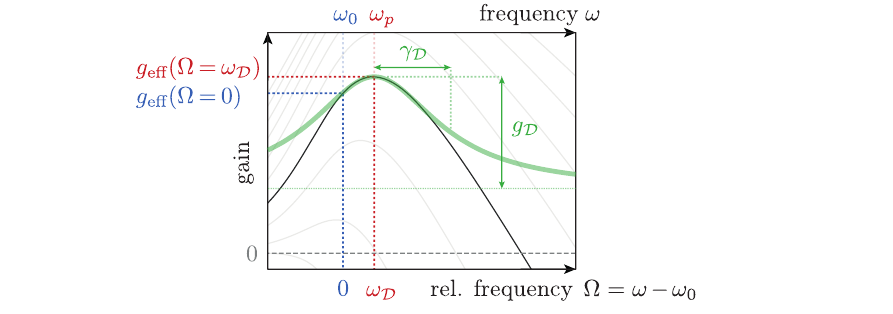
Figure A1. Illustration of the Lorentzian fitted (effective) gain spectrum and labeling of the dispersion parameters ω D , γ D , and g D . The peak gain is denoted by g eff ( Ω = ω D ) = g and g eff ( Ω = 0 ) is the effective gain at the reference frequency ω 0